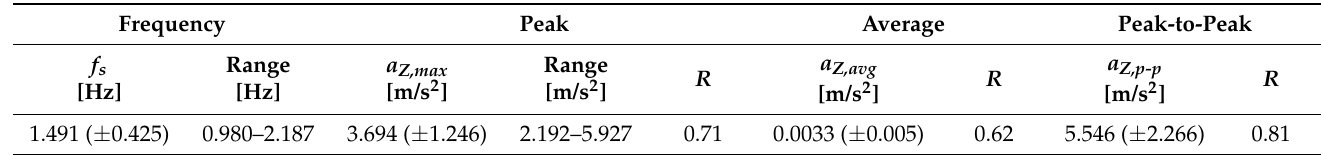
Table 4. Analysis of W5 vertical acceleration data (SLAB#1, 10 samples), with standard deviation in brackets and correlation coefficient R .